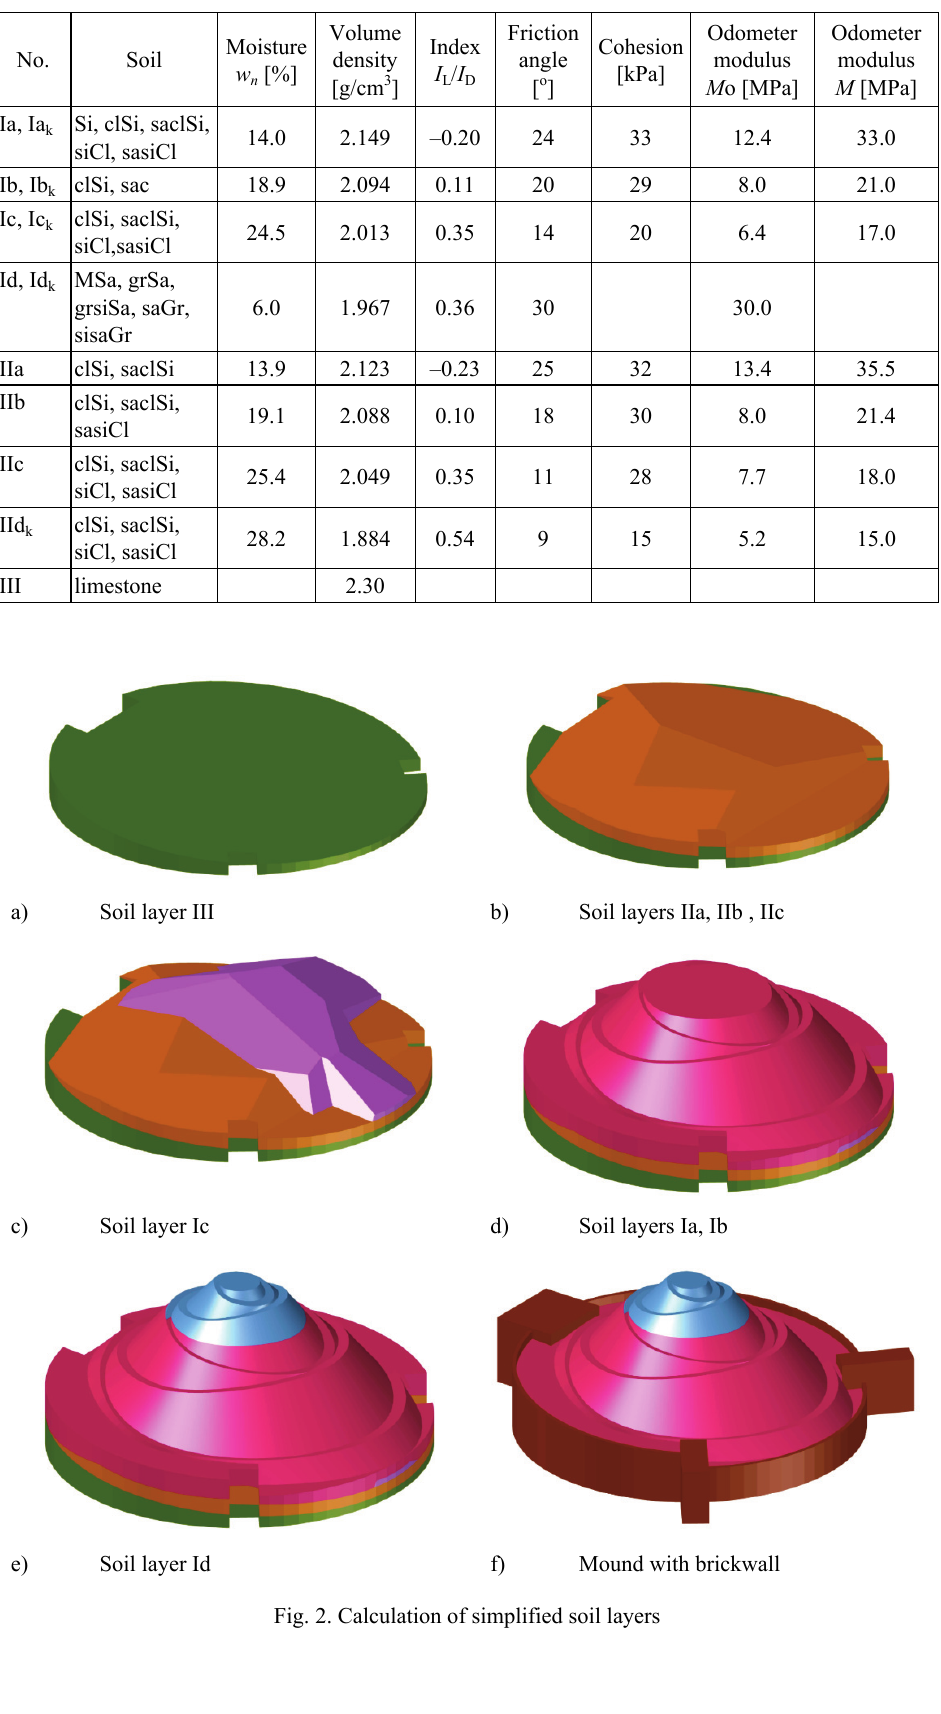
Table 1. Soil parameters of the Ko ś ciuszko Mound layers